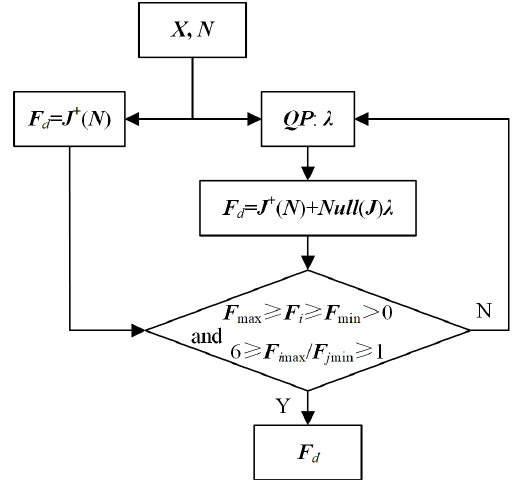
Figure 8. Tension distribution process.